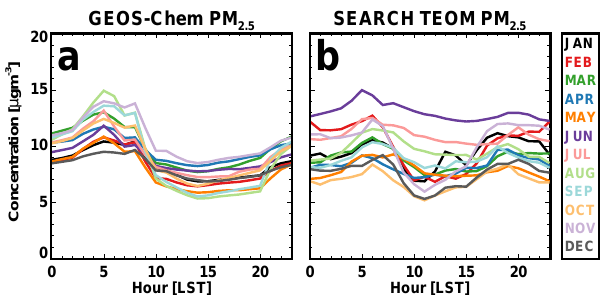
Fig. 2. Diurnal cycles of monthly mean PM 2 . 5 concentrations as simulated by GEOS-Chem (a) and as measured by TEOM filters at SEARCH network sites (b) , color-coded by month in 2009 over which the averaging was